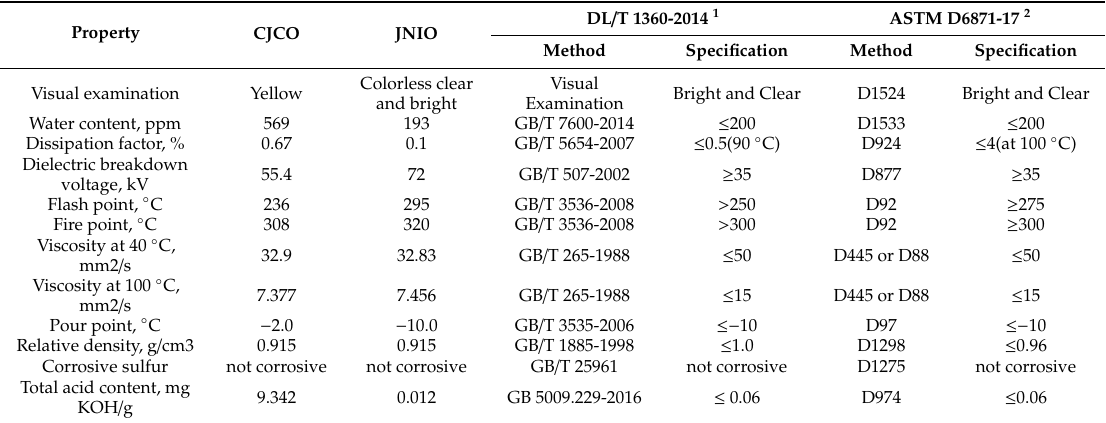
Table 2. Physicochemical Properties of CJCO, JNIO and Specifications for Natural Vegetable Insulating Oil.